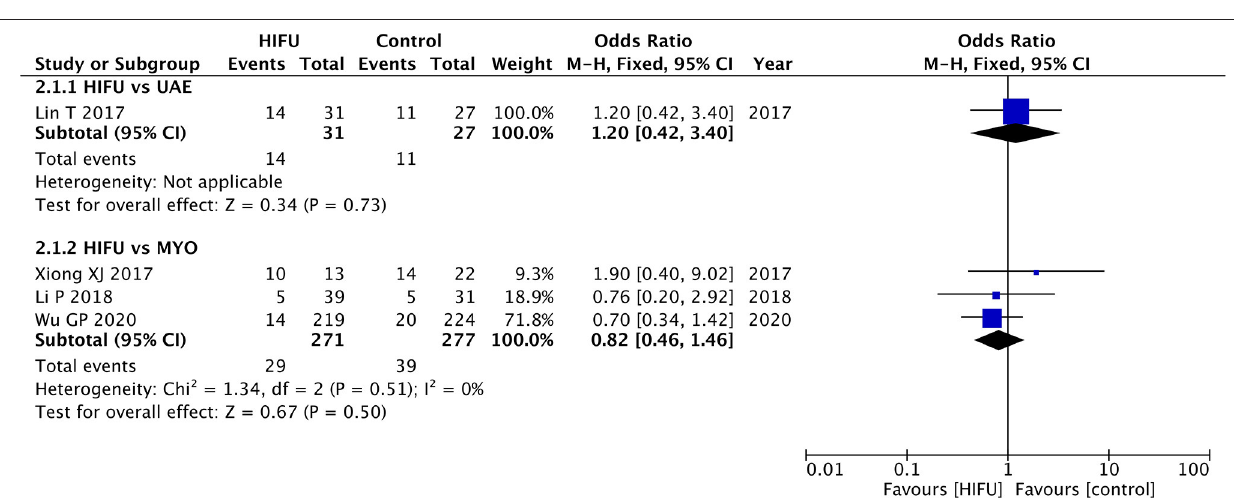
FIGURE 3 | Abnormal pregnancy incidence of HIFU in comparison with other techniques.